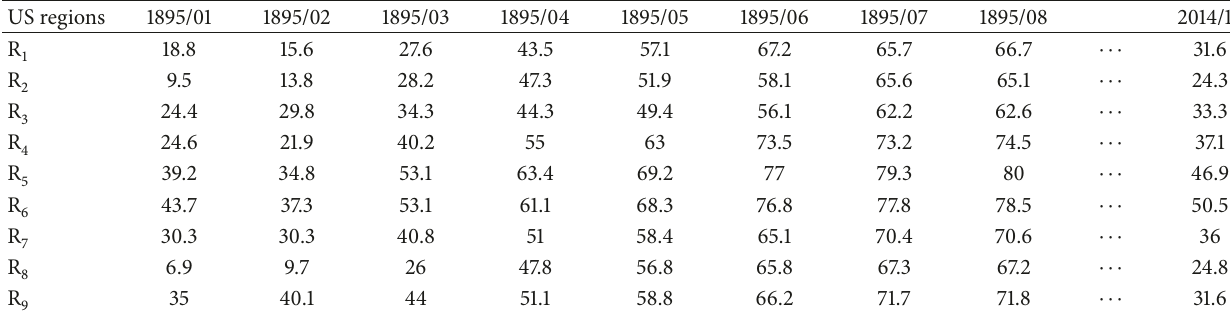
Table 1: Monthly average temperature data.